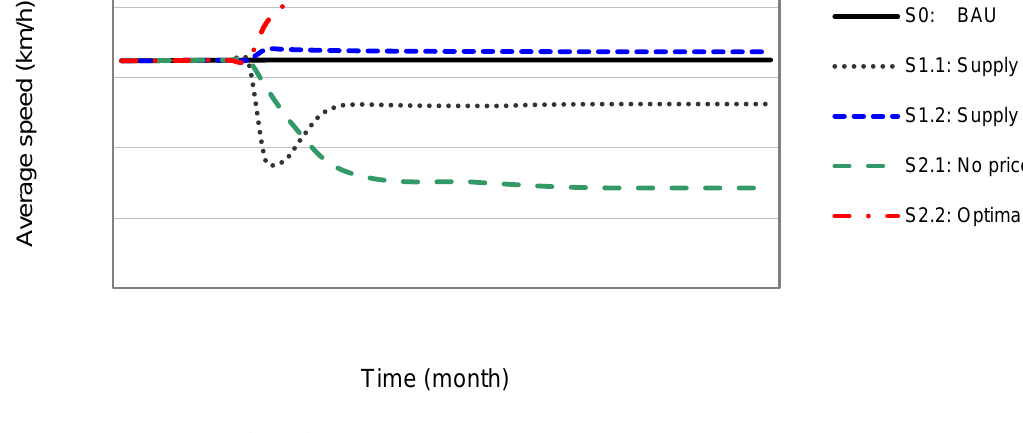
Figure 6. Average speed results